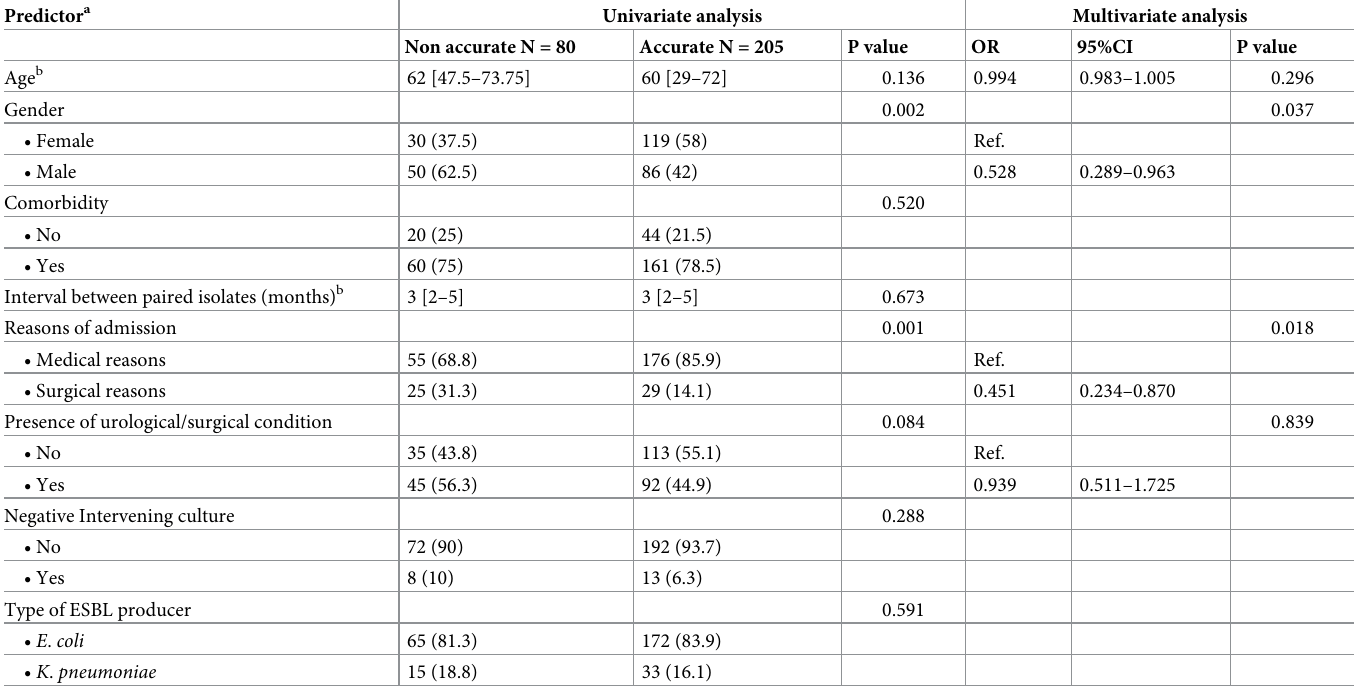
Table 3. Predictors of accurate empirical therapy of the index ESBL-UTI